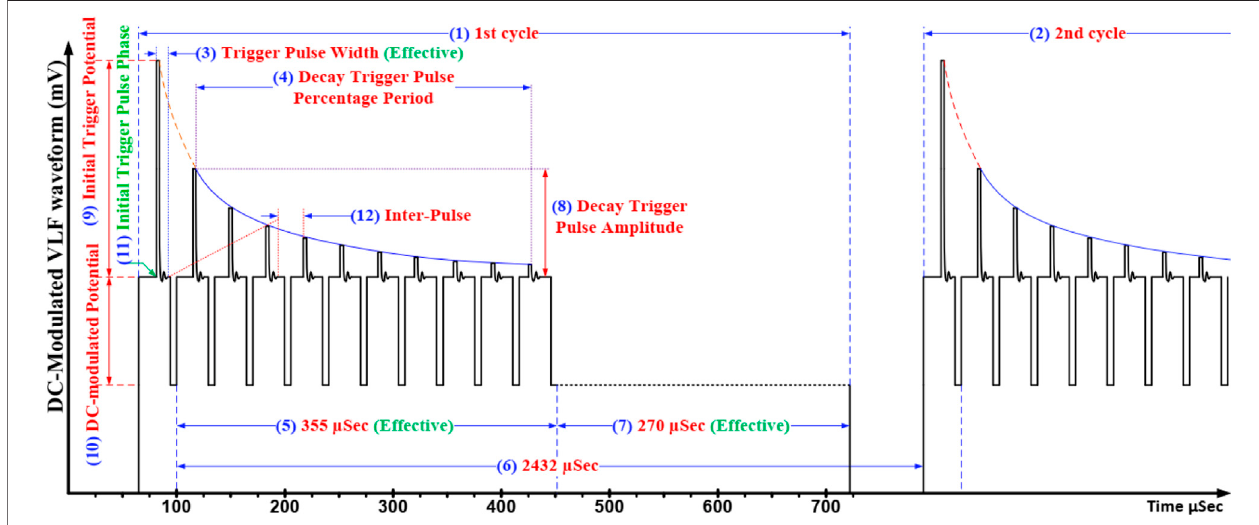
FIGURE1| SchemeoftheTPWwithallparameters. 1)1stcycle,2)2ndcycle,3)triggerpulsewidth(effective)(µs),4)decaytriggerpulsepercentage period (%),5) modulated period (effective) (µs), 6) whole period (µs), 7) cut-off time (effective) (µs), 8) decay trigger pulse amplitude (mV), 9) initial triggered potential (mV), 10) DC-